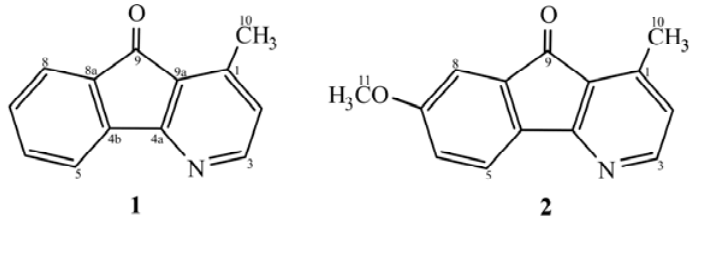
Figure 1. Chemical structures and numbering of alkaloids 1 and 2